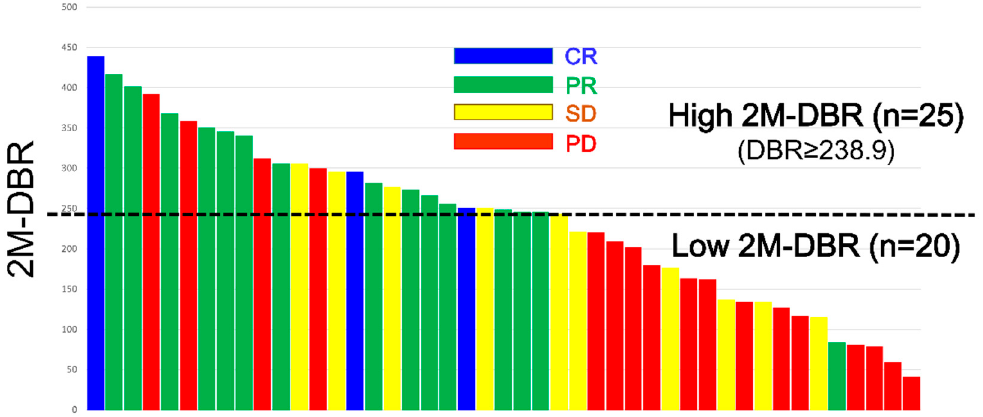
Figure 2. Responses to lenvatinib of the 45 enrolled patients were evaluated by contrast-enhanced computed tomography at 8–12 weeks, which was sorted by the delivered dose intensity/body surface area ratio at 60 days (2M-DBR).